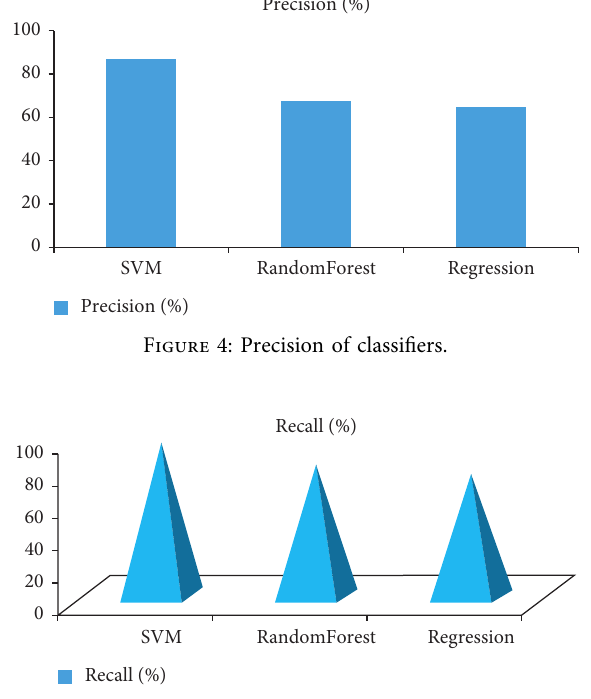
Figure 5: Recall of